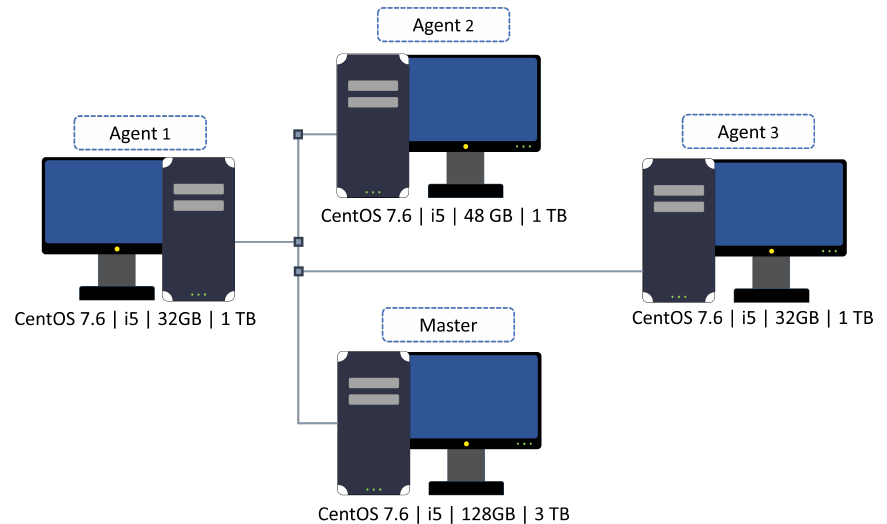
Figure 9. Distributed platform for experimental